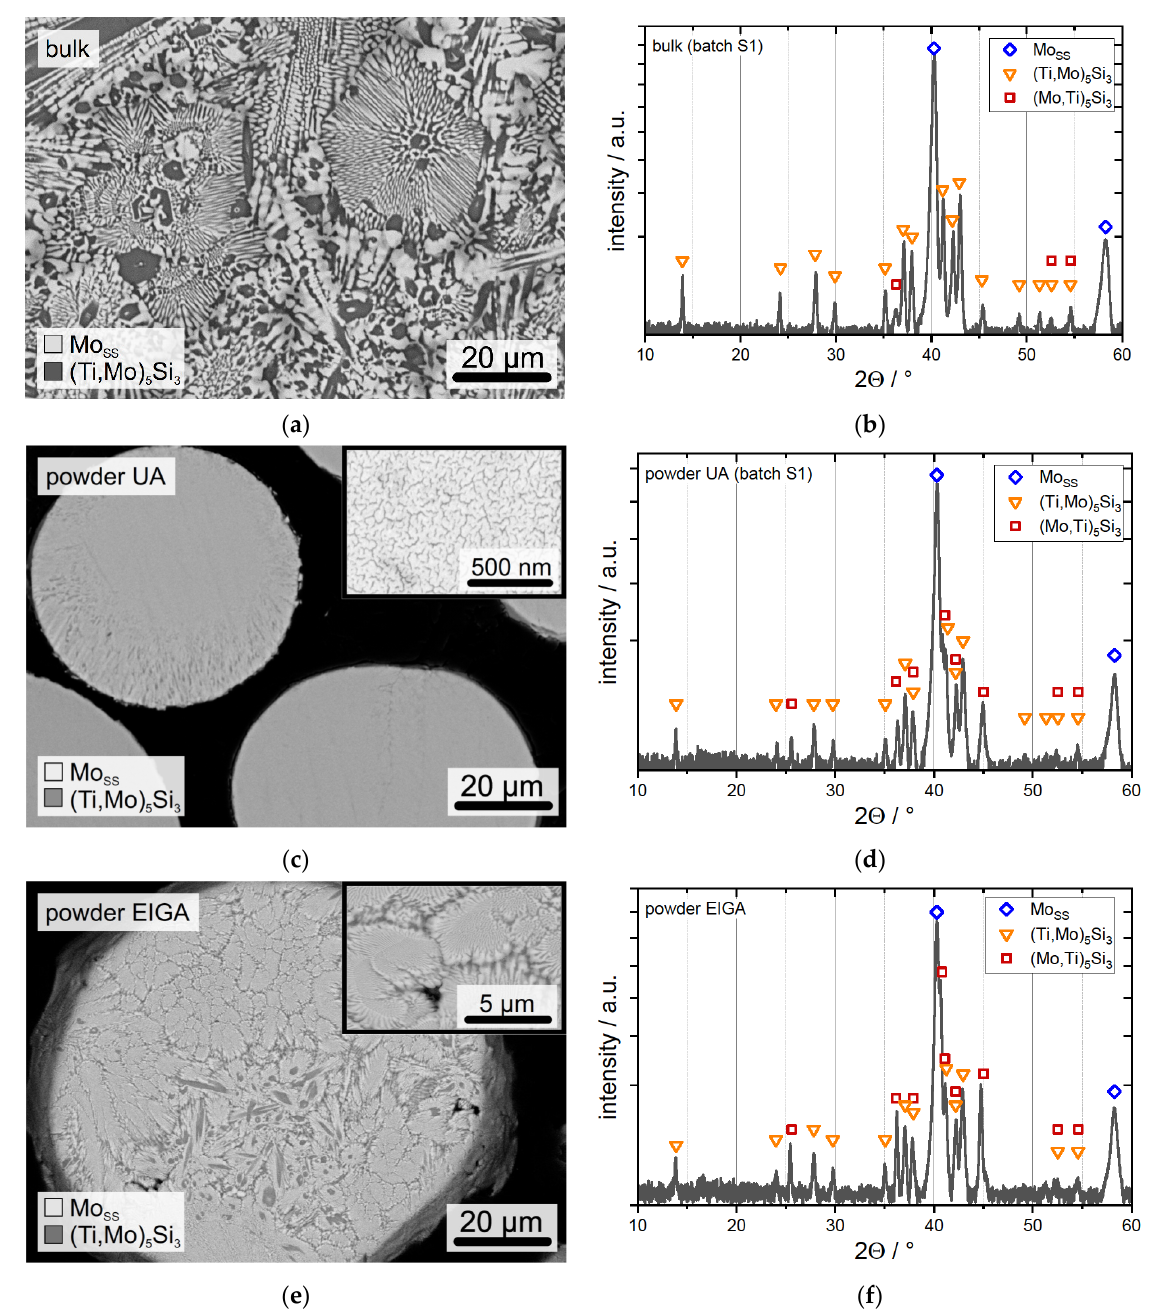
Figure 4. SEM BSE micrographs of the microstructures ( a , c , e ) and XRD patterns ( b , d , f ) of the as-cast material ( a , b ), UA powder ( c , d ), and EIGA powder ( e , f ). The intensity axes of the XRD patterns are plotted with square root scale in order to improve visibility of low-intensity Bragg peaks.